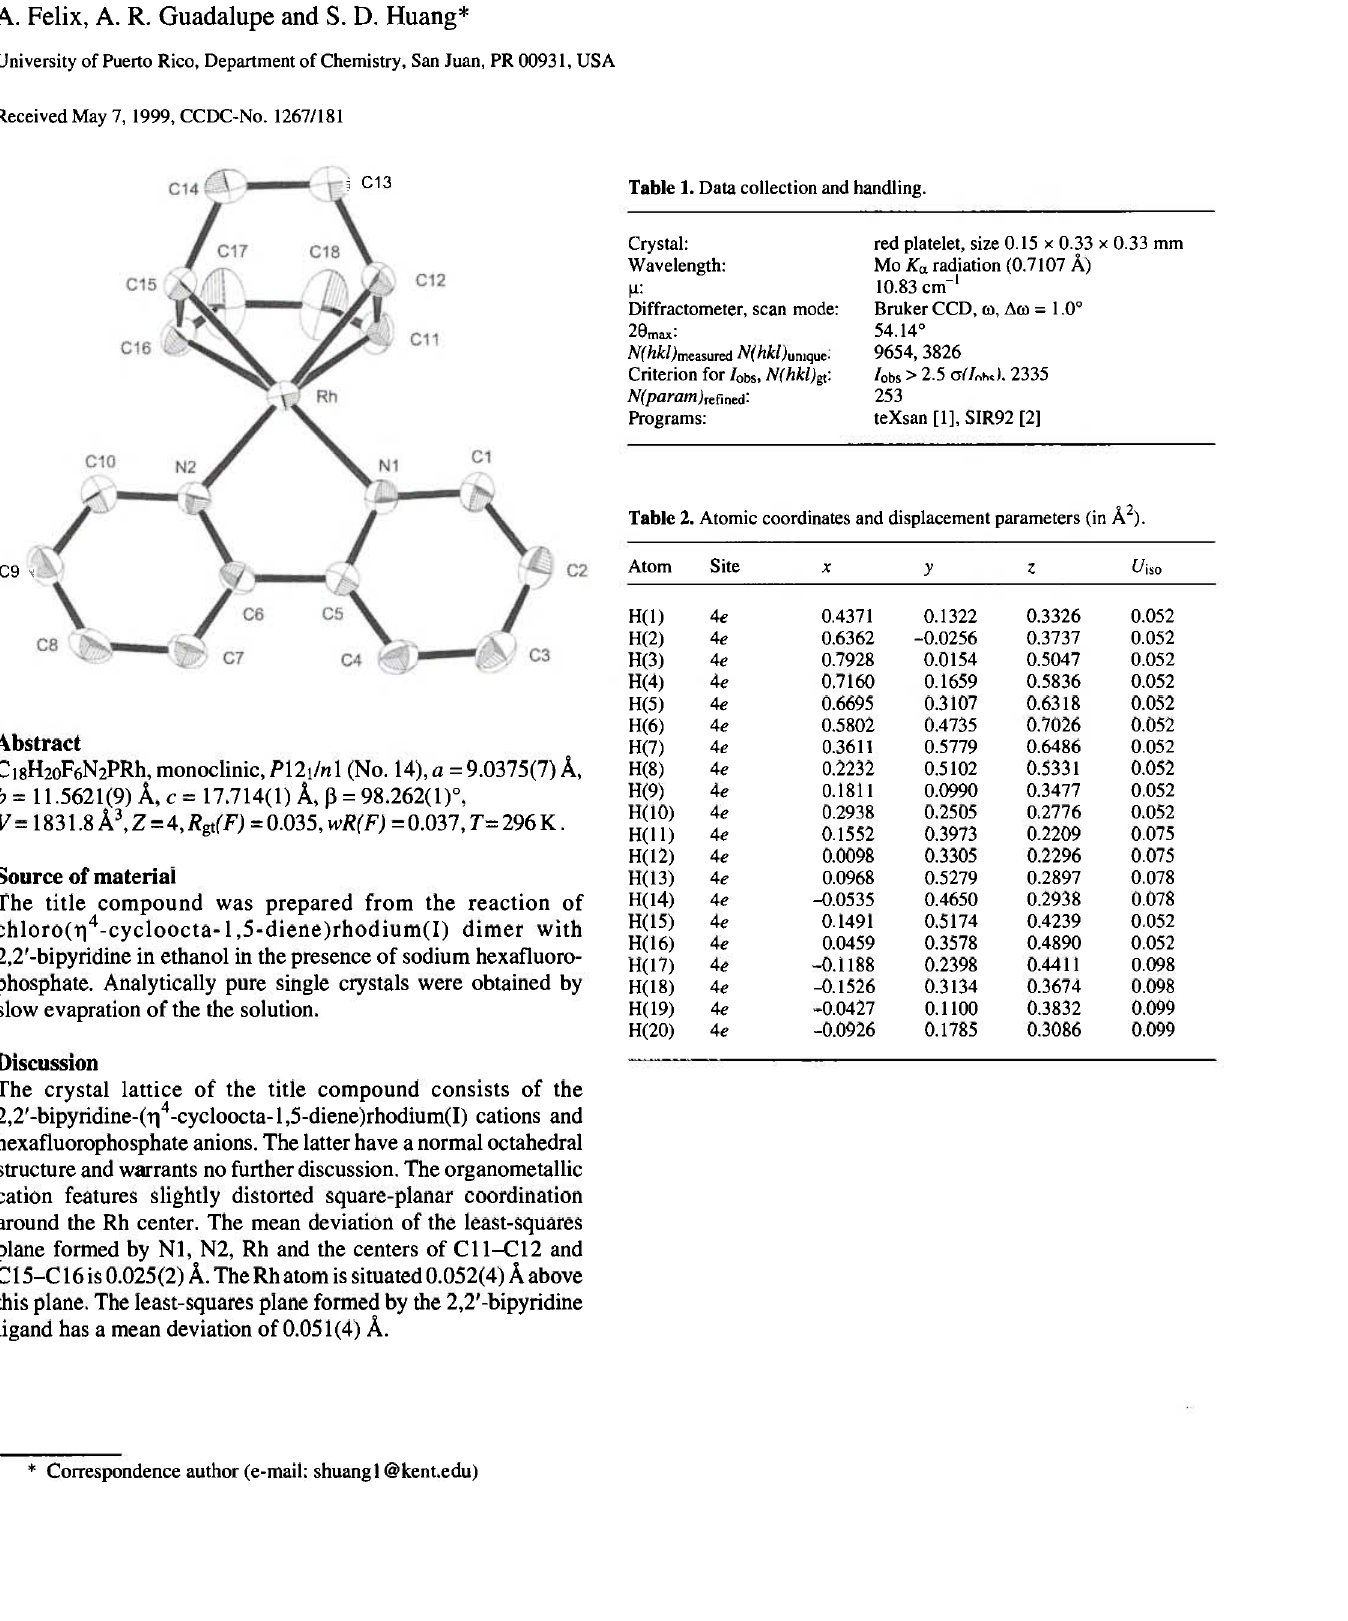
Table 1. Data collection and handling.